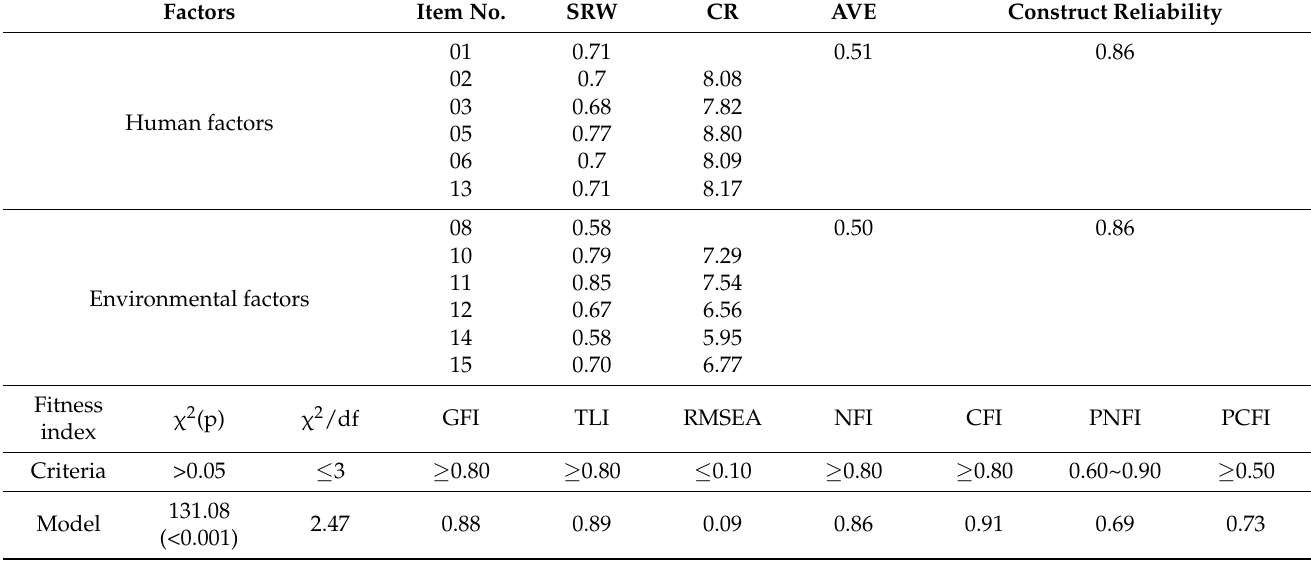
Table 3. Confirmatory factor analysis (N =